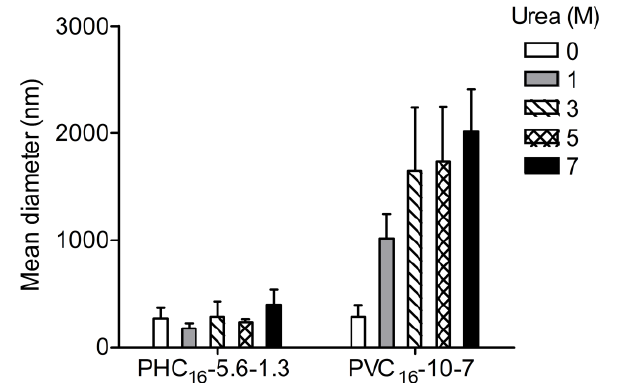
Figure 7. Influence of urea (0–7 M) on the size of pullulan-C measured at 37 °C in DLS (mean ± S.D., n =